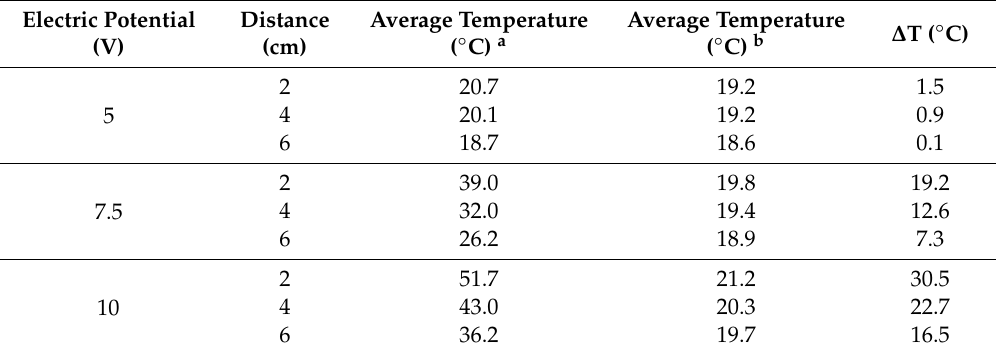
Table 5. Thermal variation ( ∆ T) between the infrared thermography values recorded for EM4 and EM3 with random fibers